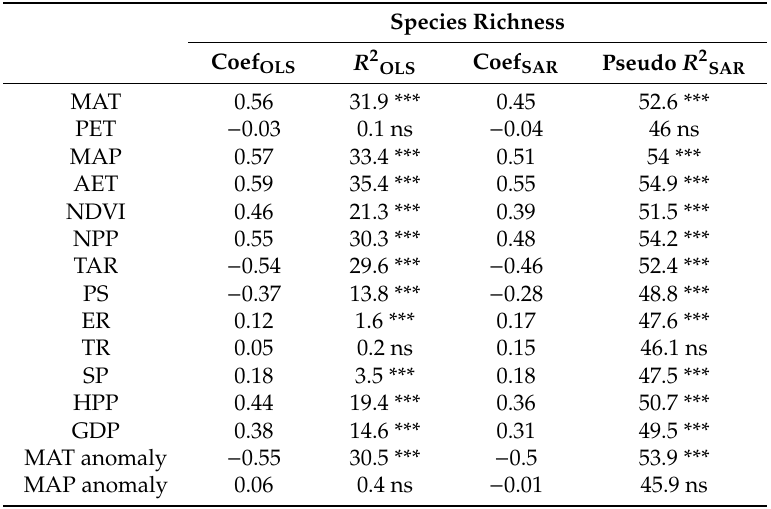
Table 2. Univariate relationships between species richness and environmental variables using ordinary least squares (OLS) and spatial error simultaneous autoregressive (SAR err ) models. Coefficients (coef), R 2 (%), and Pseudo R 2 (%) are shown. For the variable abbreviations, see Table 1.